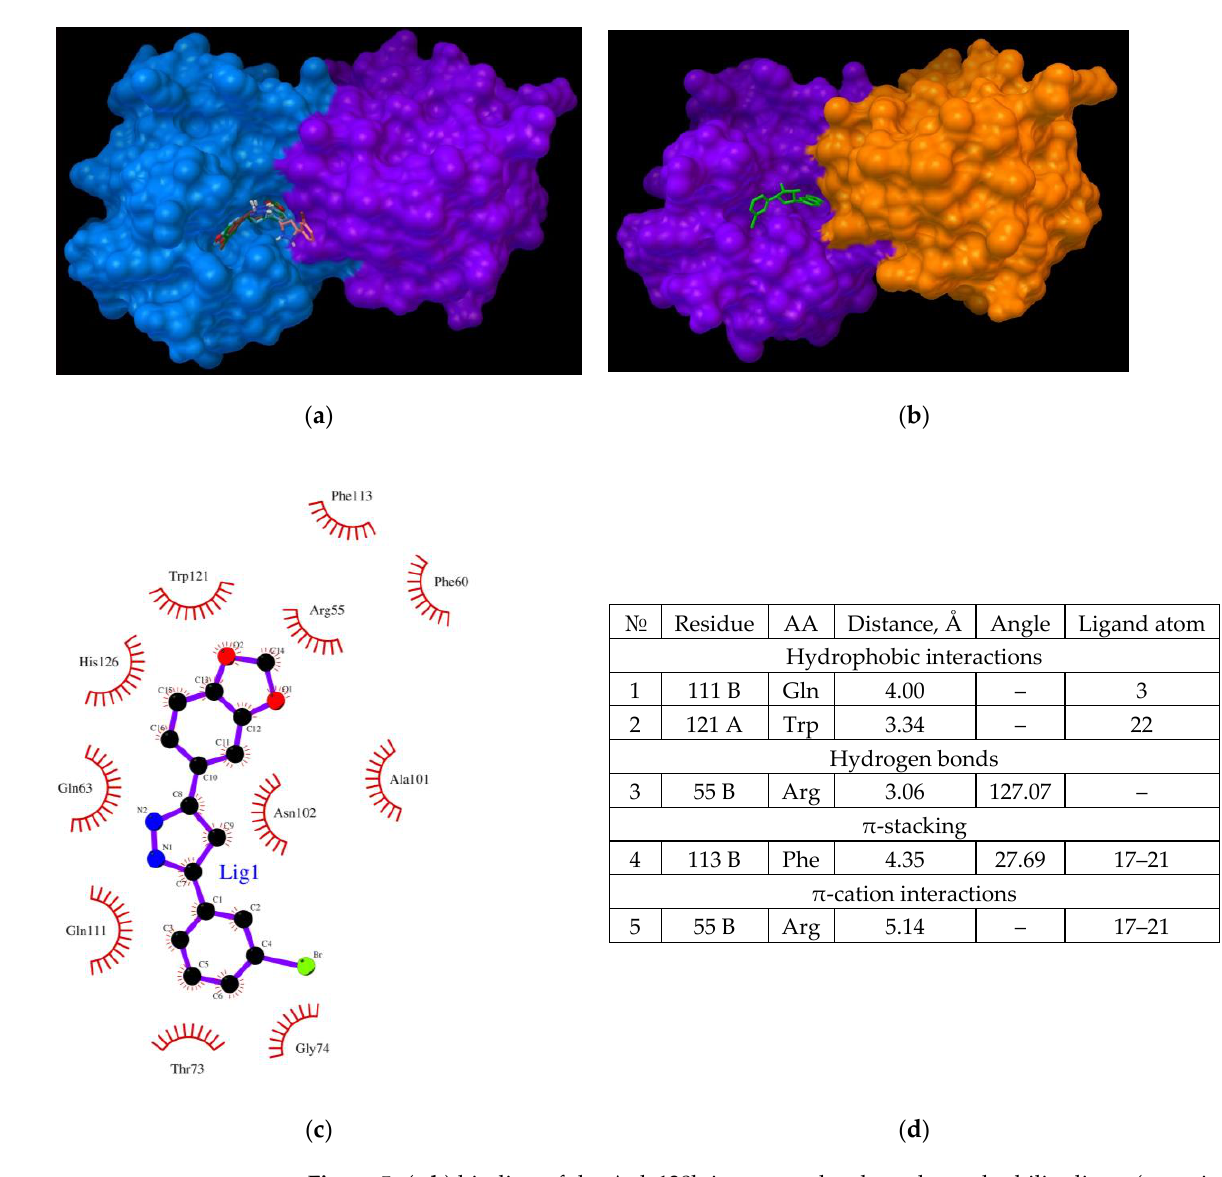
Figure 5. ( a , b ) binding of the Anle138b isomer molecule to the cyclophilin dimer (two views); ( c ) interactions diagram of Anle138b isomer with cyclophilin dimer; ( d ) interaction options for Anle138b isomer binding to the CypA